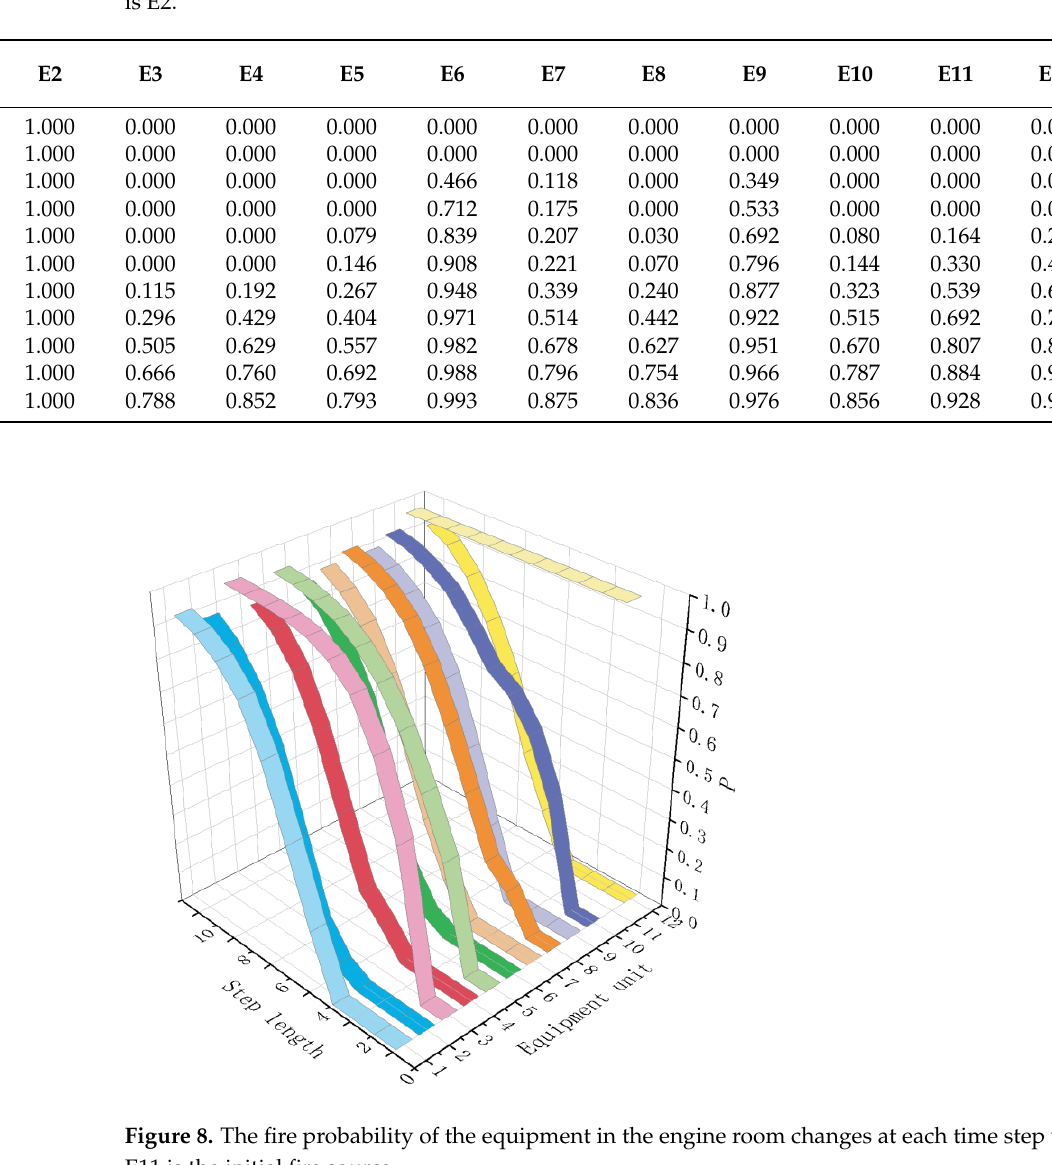
Table 8. Fire probability of equipment in an engine room at each time step when the initial fire source is E2.